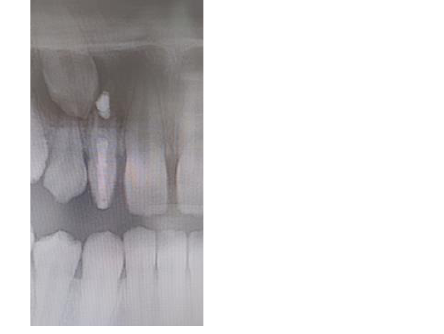
Figure 5. Endodontic treatment of PMLI with dens invaginatus.